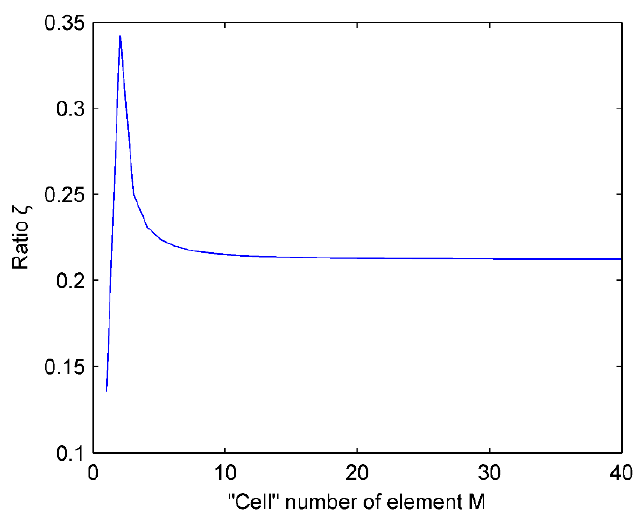
Figure 9. Influence of “cell” number of element on the ratio ξ .